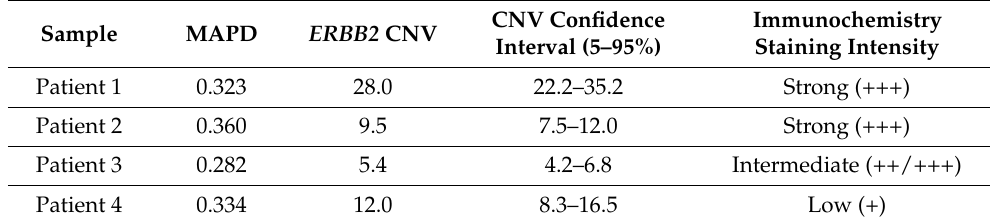
Table 2. Inter-run variation of gene amplification analysis using HD789 QC material in 20 consecu- tive runs.